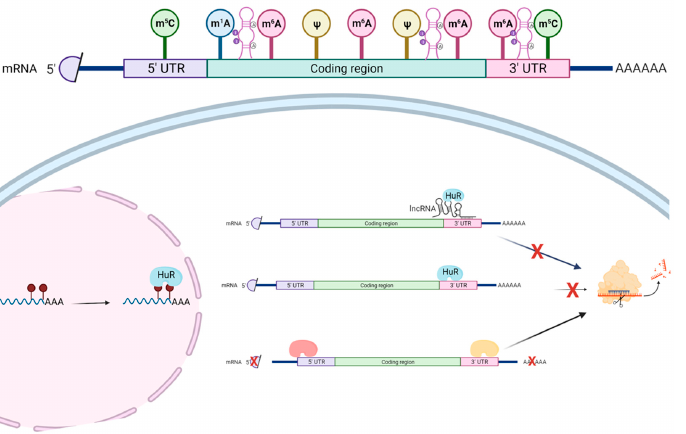
Figure 2. The roles of RBPs in the epitranscriptomic context. The most common epitranscriptomic marks include 5-methylcytosine (m 5 C), N1-methyladenosine (m 1 A), N6-methyladenosine (m 6 A), pseudouridine ( Ψ ), as well as A-I RNA editing. These marks affect the structures of RNA and, thus, influence the binding of RBPs. RNA-edited sites are preferentially bound by HuR—a RNA-stabiliz- ing RBP. Furthermore, several lncRNAs, including LINC02381 , are found to be bound by HuR, which stabilizes the 3 ′ -UTR of the mRNA. Other RBPs could promote RNA degradation. Figure is created with BioRender.com, accessed on 16 March